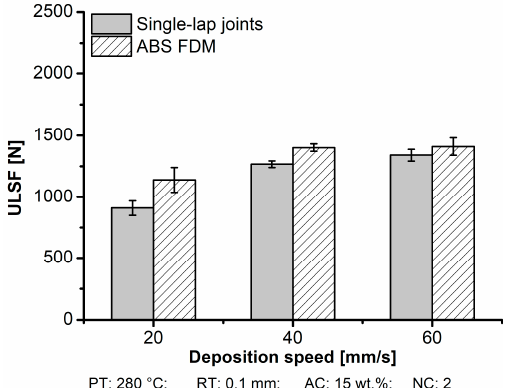
Figure 18. Influence of the deposition speed on ULSF for the aluminum 2024-T3/ABS hybrid joints (single-lap joints) and ABS BM FDM (condition four, RT: 0.1 mm; condition three, RT: 0.2 mm; condition